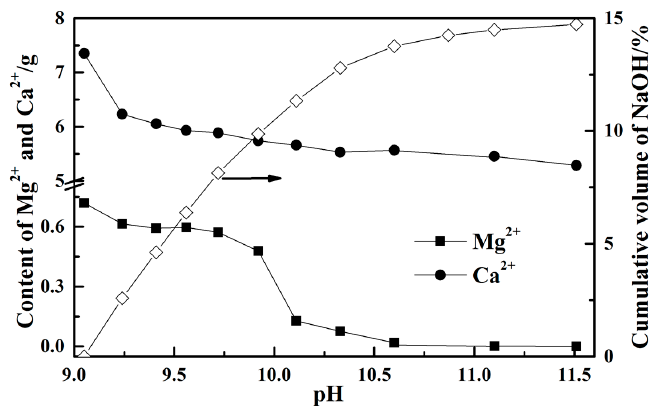
Figure 8. The added volume of NaOH and the content of Mg 2+ /Ca 2+ versus pH.